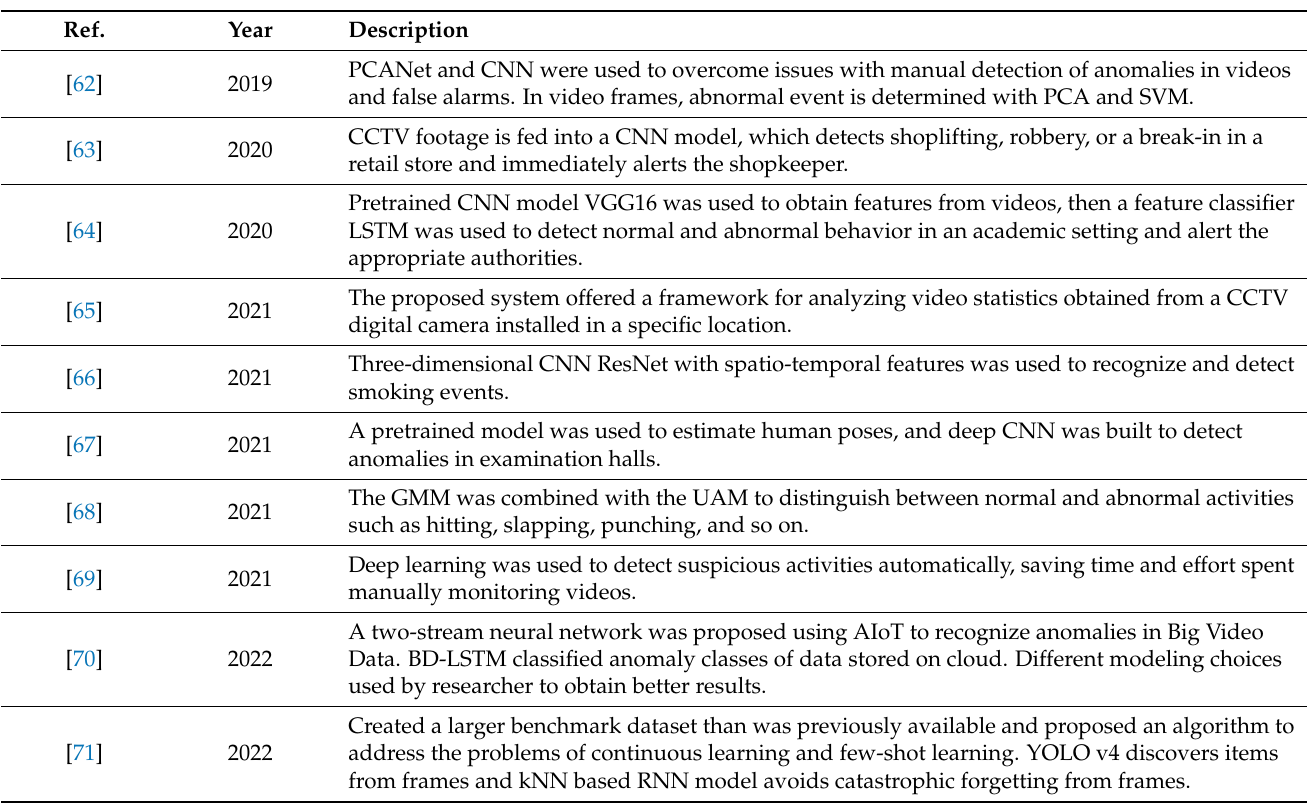
Table 4. Summary of literature on suspicious